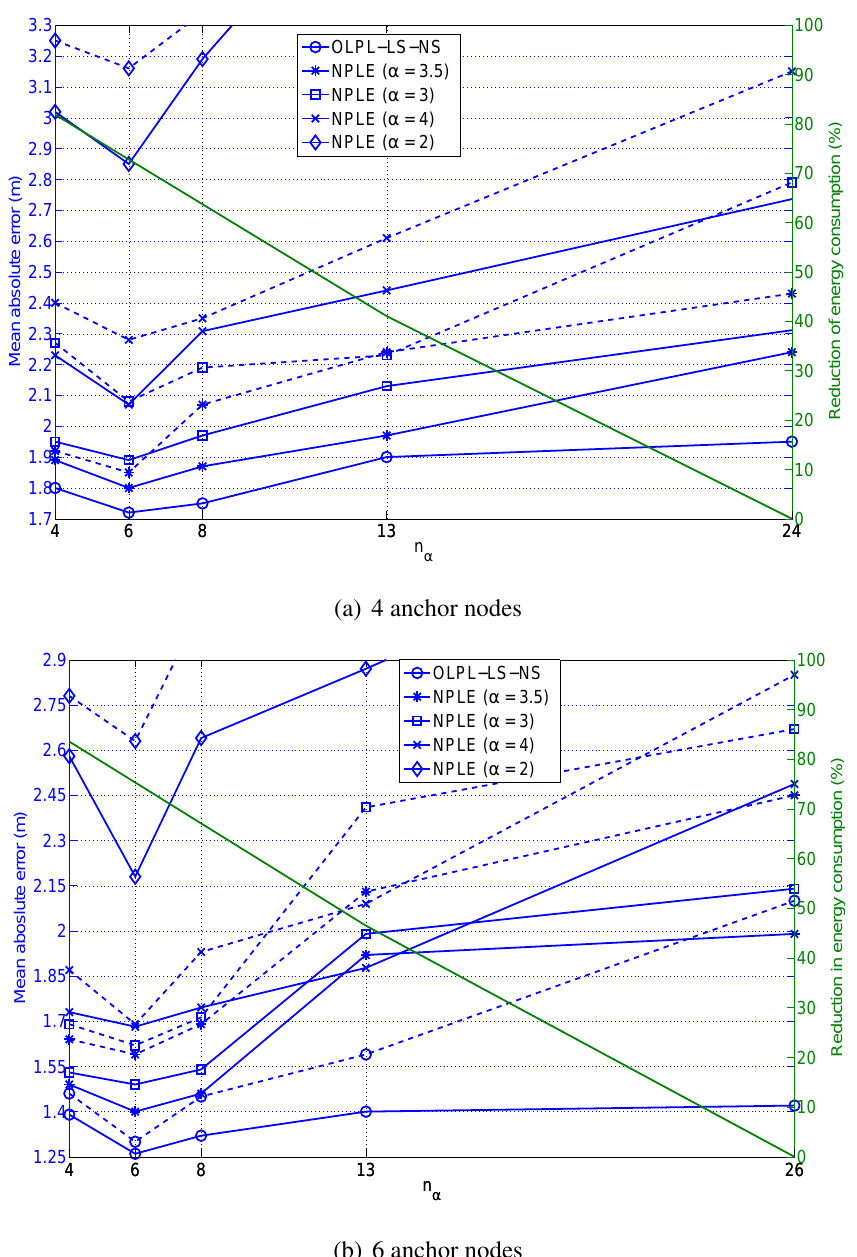
Figure 12. Mean absolute error versus number of cooperating nodes ( n δ ) (solid line: experimental results, dashed line: simulation results.)